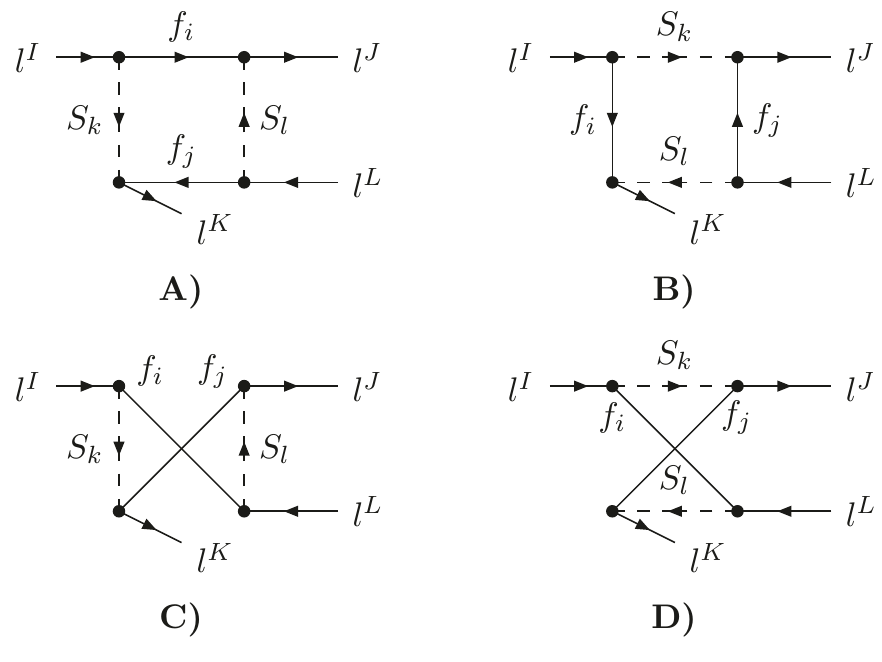
Figure 13 . MSSM box diagrams with 4 external charged